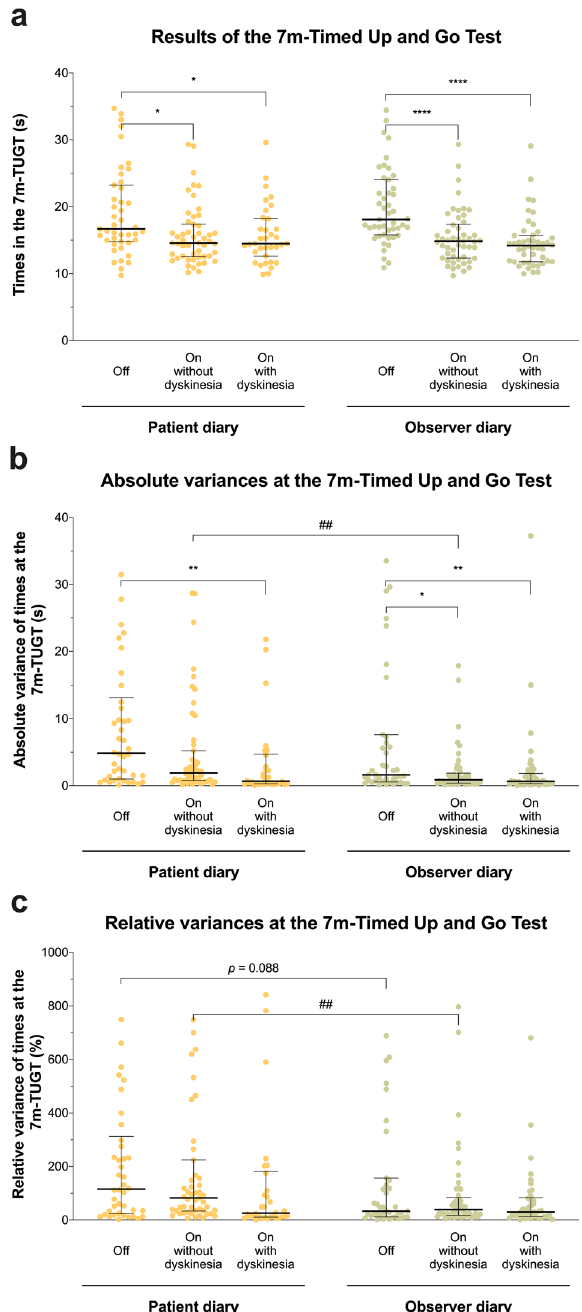
Fig. 3 Results from 7-meter Timed Up and Go Tests with respect to diary-documented motor states. a The results of 1917 half- hourly performed 7-meter Timed Up and Go Tests (TUGT) in 51 patients with Parkinson ’ s disease with respect to Off, On without dyskinesia and On with dyskinesia as documented in the patient diary (left hand side, yellow colour) and observer diary (right-hand side, green colour). b Illustrates absolute variances during the 7-m TUGT in respective motor states. c Displays relatives variances after individual normalization of measured 7-m TUGT times to the mean time achieved by a patient in the respective motor state. Single dots indicate mean values for individual patients, black bars and whiskers represent medians ± interquartile ranges for the entire cohort. * P < 0.05, ** P < 0.01 and **** P < 0.0001 from Kruskal – Wallis tests with Dunn – Bonferroni post-hoc tests, corrected for multiple compar- isons. ## P < 0.01 from Mann – Whitney test. 1 ( a ), 7 ( b ) and 11 ( c ) data points are not shown to allow for proper scaling of the graphs.